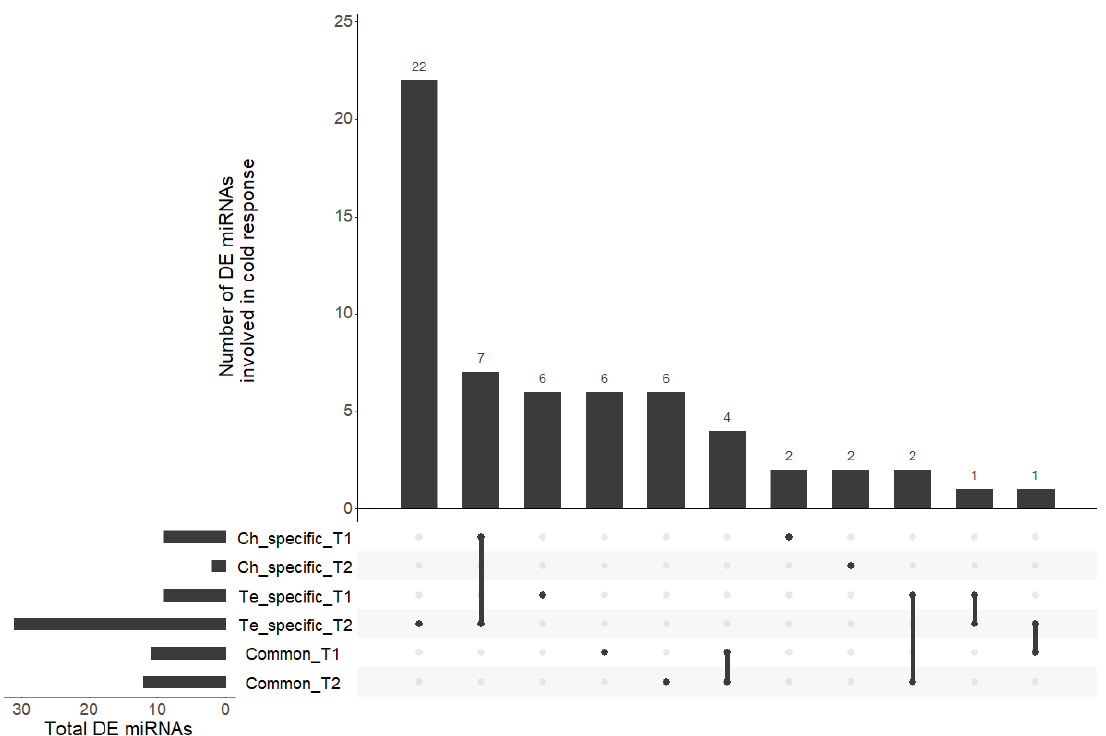
Figure 2. UpSet plot of the six lists of differentially abundant miRNAs. All intersections of the six sets of miRNAs are sorted by size. Dark circles in the matrix indicate sets that are part of each intersection.